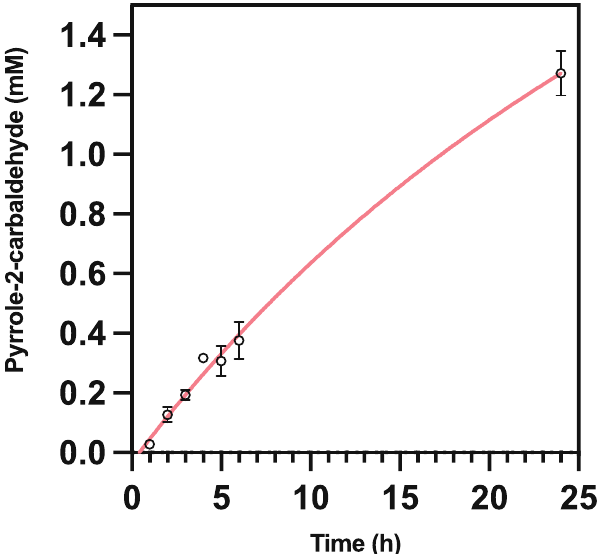
Figure 7. Time course analysis of pyrrole-2-carbaldehyde production from whole-cell CARse and Purified PA0254 supplied with 10 mM pyrrole, performed over a period of 6 h. Comparative data points from 24 h of incubation displayed for clarity. No carboxylation of pyrrole was observed in controls lacking biocatalyst at any time point.